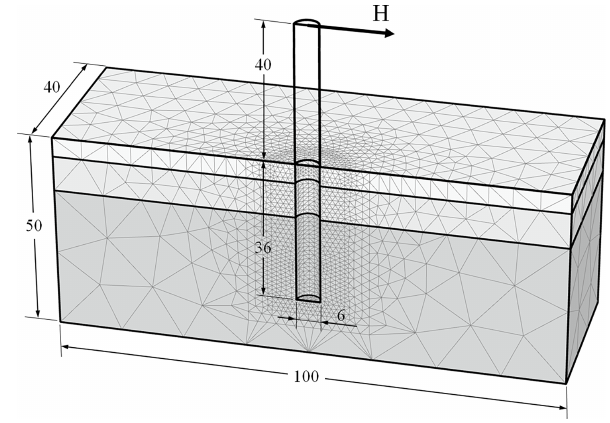
Figure 13. Mesh and dimensions (in meters) of the finite element model.